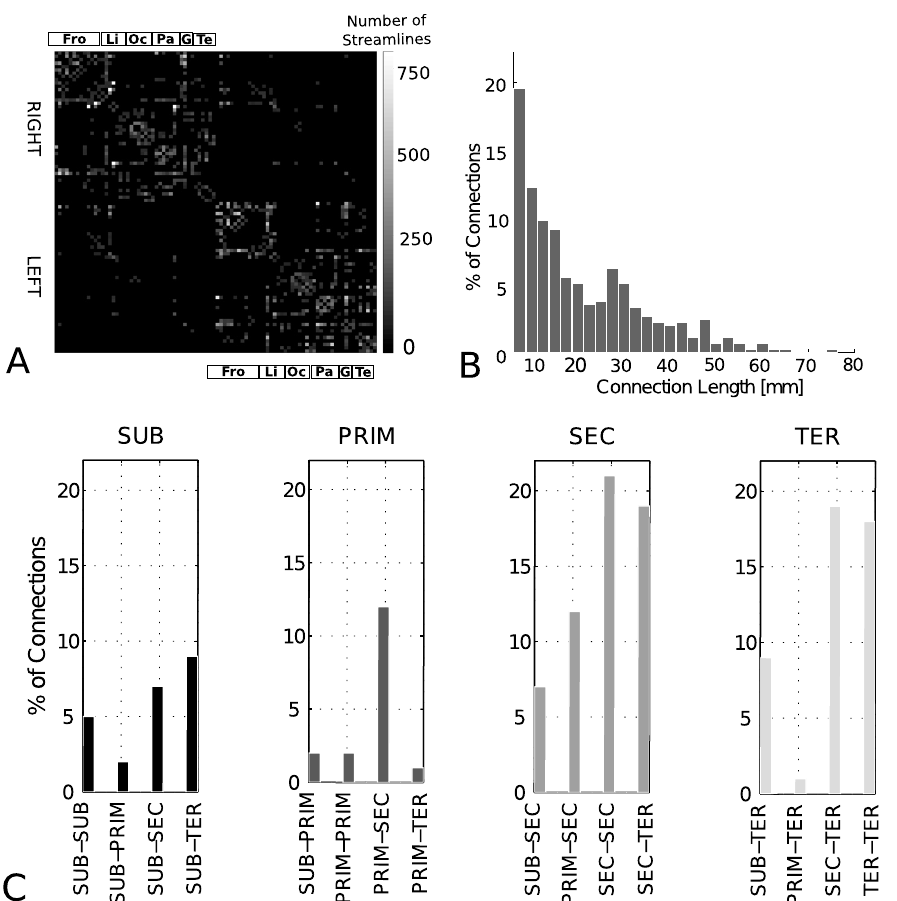
Fig 1. Connection properties. A: Weightedgroupwiseconnectivity matrix including450 connections present for > = 50% of the subjects. Color coding indicatesthe numberof streamlines. ROIs are orderedper hemisphere (right: top, left: bottom) accordingto the atlas by Shi et al. [43]. Fro: frontal; Li: limbic; Oc: occipital;Pa: parietal; Te: temporal cortex and G: basal ganglia. B: Length distributionof the 450 connections. C: Connectionrepartitionbetweenthe different groups. SUB in black, PRIM in dark gray, SEC in gray, TER in light gray.